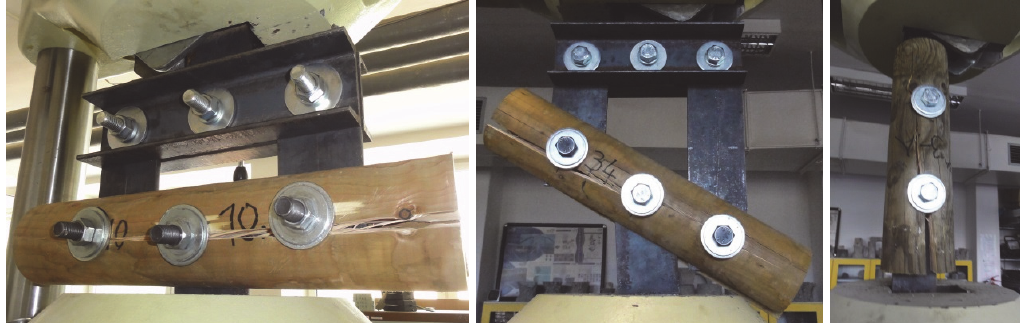
Figure 5: Damaged round timber samples loaded in tension at different angles.